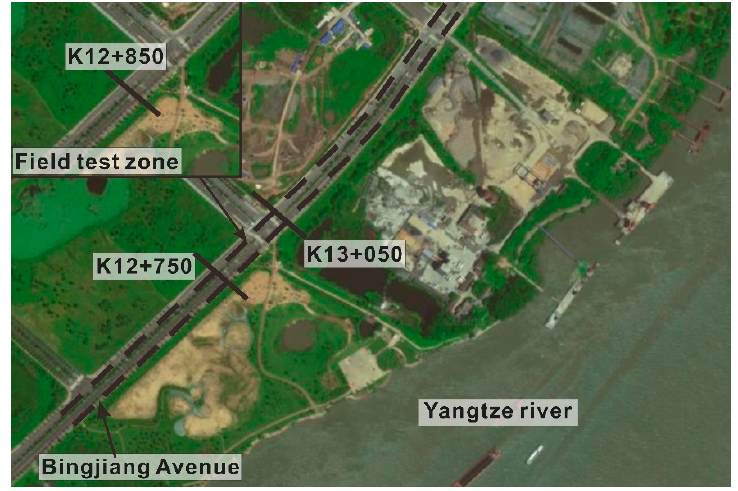
Figure 1. The field test zone.